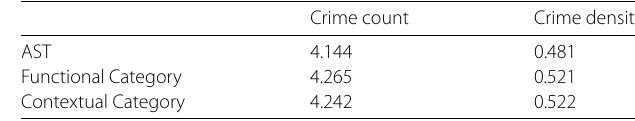
Table 4 Prediction performance